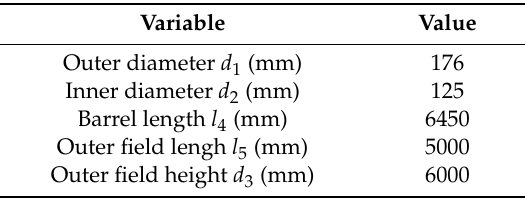
Table 1. Specification of 125 mm gun.